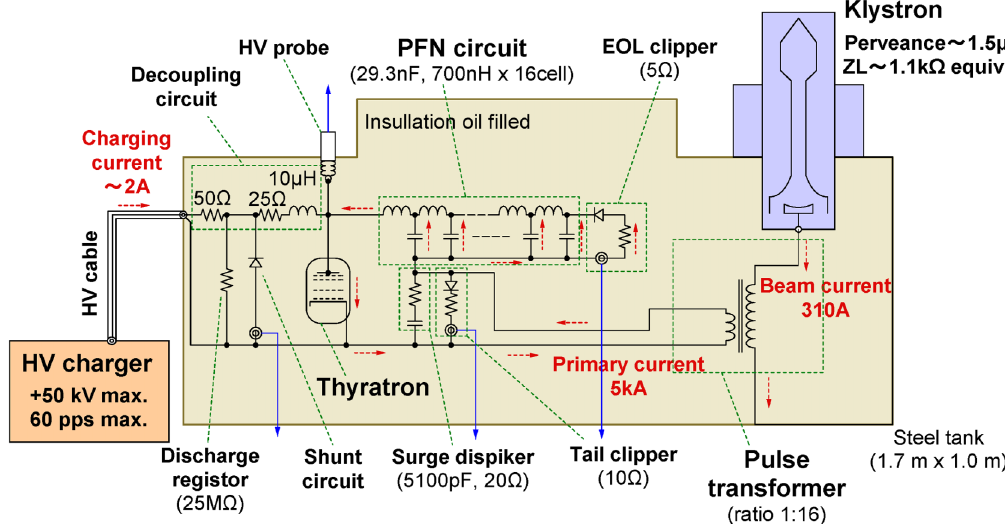
FIG. 10. Schematic of the klystron modulator. Typical charging current, primary pulse current and the secondary current for nominal operation are listed in the figure.